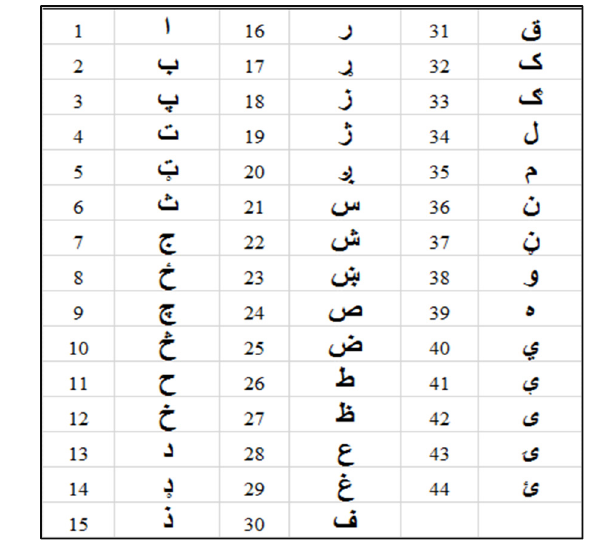
Fig. 1: Pashto Character Set